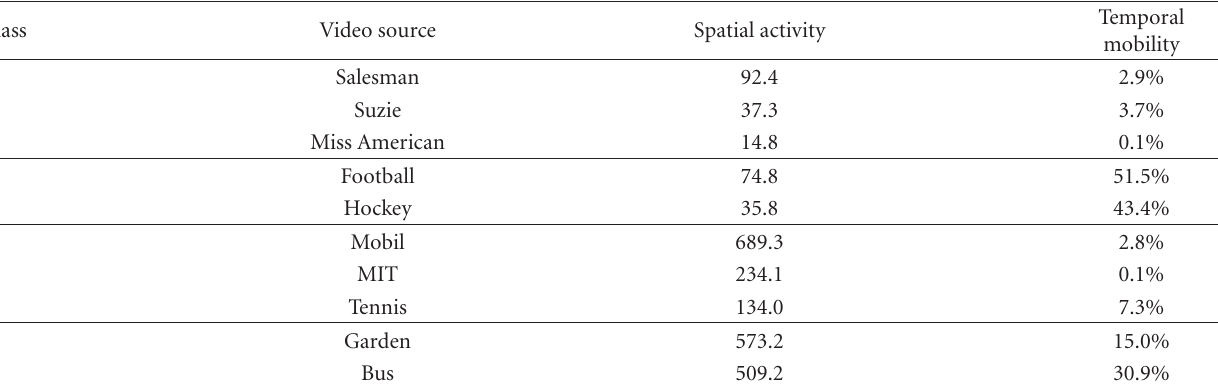
Table 1: Activity and mobility of video sequences.